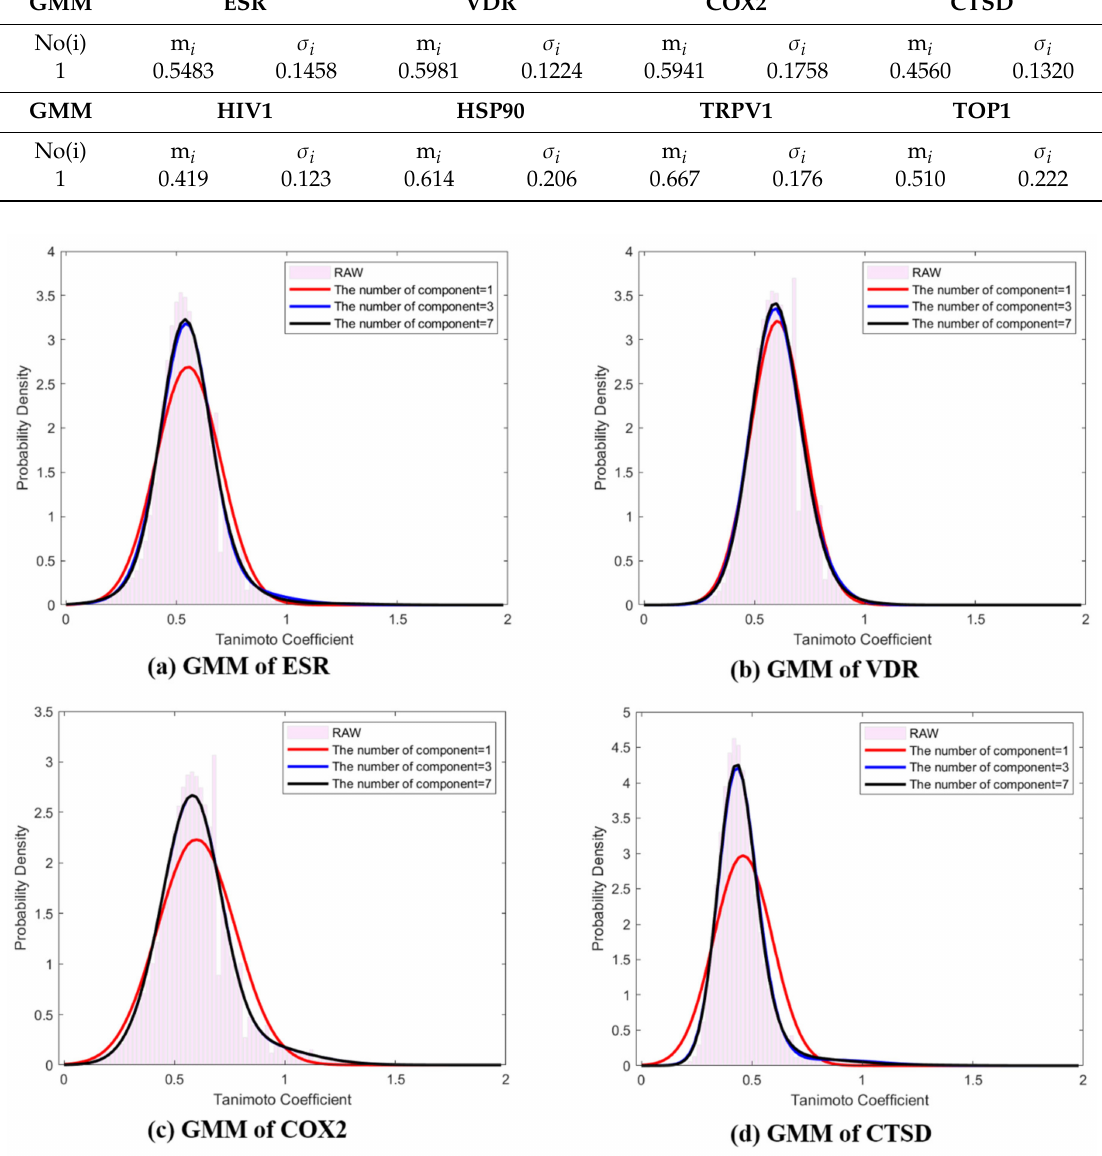
Figure 2. Representative distributions ( Q -distributions) of target classes using EM based Gaussian (cid:12) (cid:12) mixture model ( Ξ EM ( Φ n ( x ) (cid:12) g , ω , µ , σ , K ) of ligand pair similarity. ( a ) Q -distribution of ESR; ( b ) Q -distribution of VDR; ( c ) Q -distribution of COX2; ( d ) Q -distribution of CTSD. The red line: GMM K = 1, blue line: GMM K = 3, black line: GMM K = 7, pink bar: histogram of raw